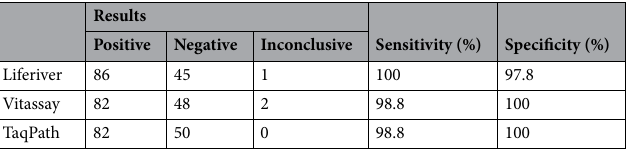
Table 4. Differences in analytical sensitivity and specificity between the studied SARS-CoV-2 kits in clinical samples.